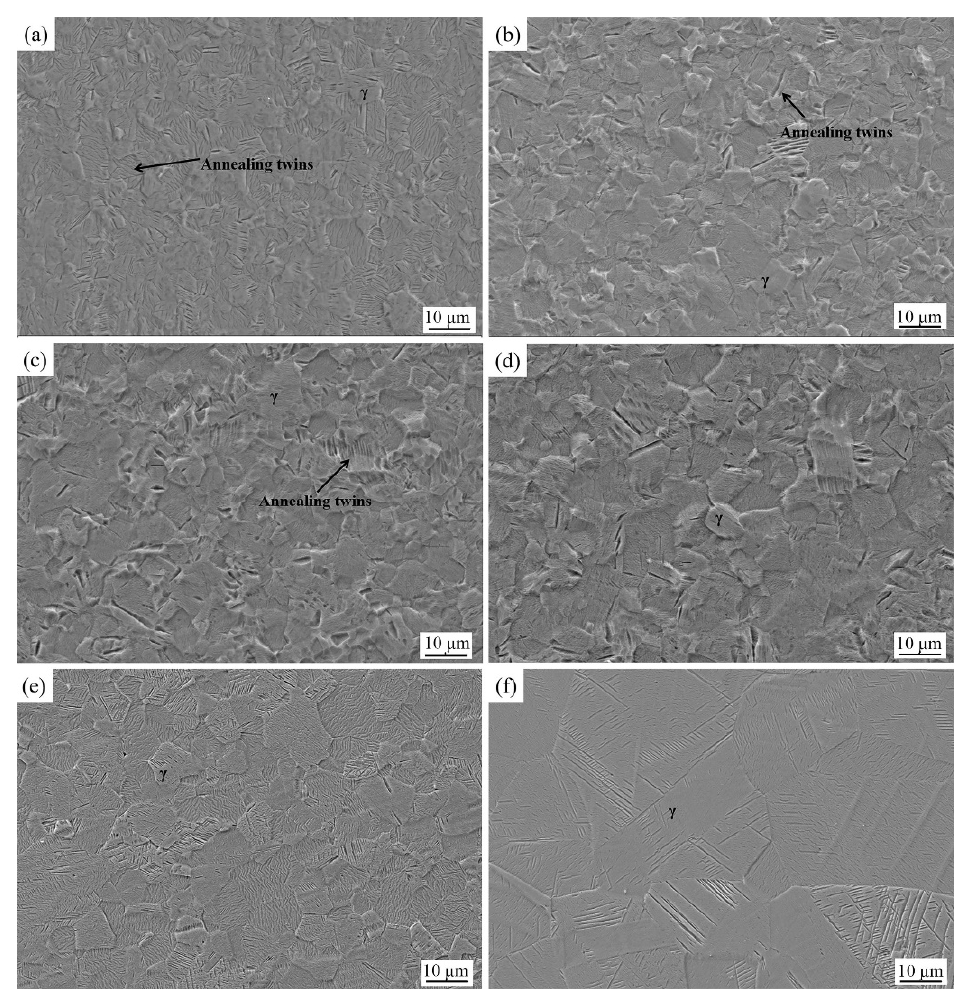
Figure 3. SEM micrographs of steel 2# under different solid solution temperatures: ( a ) 650 °C, ( b )